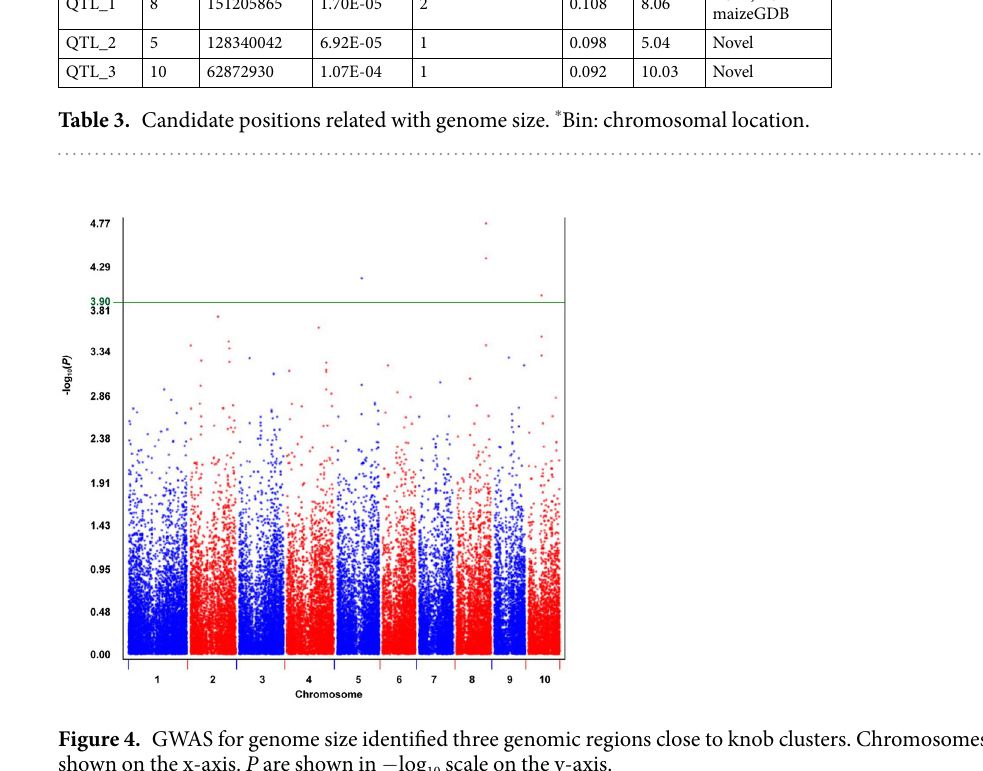
each maize inbred line were sent to PLANT CYTOMETRY SERVICES in the Netherlands for determination of absolute DNA content of plant nuclei (C-value). For each inbred line, DNA content was measured from three bio- logical replicates and two technical replicates using flow cytometry as described in Enke et al . 46 . Genome size was estimated in picograms (pg) per 2 C nucleus using the nuclear DNA content of Vinca major , which is an evergreen plant with a relatively small DNA content (4.20 pg/2 C) compared to that of Zea mays , as an internal standard. Nuclear DNA content for the unknown samples (maize inbred lines) was calculated using the following formula 47 :